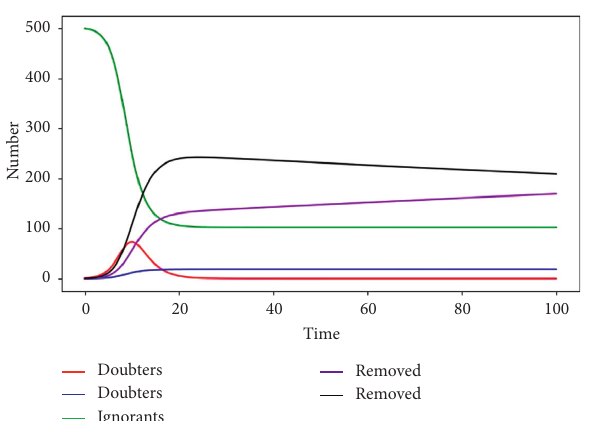
Figure 3: The stability of φ 0 in system (1) with R 0 < 1.